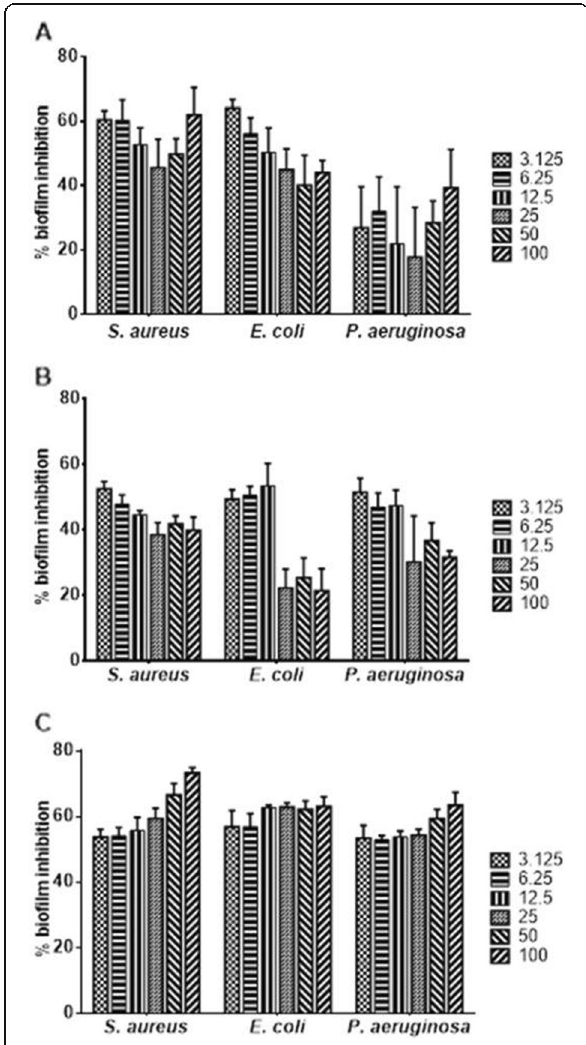
Fig. 3 Anti-biofilm formation effect of compounds 1 – 3 (A-C) in S. aureus , E. coli and P.